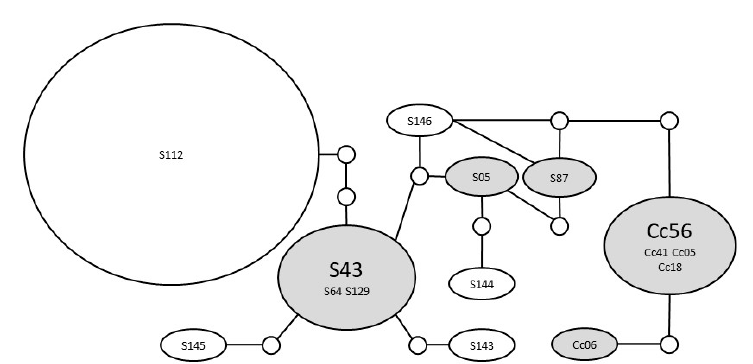
Figure A1. Haplotype network for chloroplast haplotypes found in the Californian landrace of Eucalyptus globulus. Circle sizes represent number of individual trees found to contain each haplotype. Haplotypes that have been found in the native population in Australia are shaded. Unshaded haplotypes have so far not been found in Australia, except for S112 which has been found only in ornamental plantings. Within the native range of E. globulus in Australia, the S haplotypes are found only in eastern Tasmania. Although Cc haplotypes are found in Victoria, the Furneaux Islands and Tasmania (Freeman et al., 2007), the specific haplotypes shown here are confined to either eastern Tasmania (Cc05, Cc06, Cc41 and Cc56) or eastern Tasmania and King Island (western Bass Strait) (Cc18). The native distributions of haplotypes Cc41, Cc56 and S43 are mapped in Freeman et al. (2007). The positioning of the haplotypes Cc56, Cc41, Cc06 and S43 within a broader network of E. globulus haplotypes is shown in McKinnnon et al. (2004).